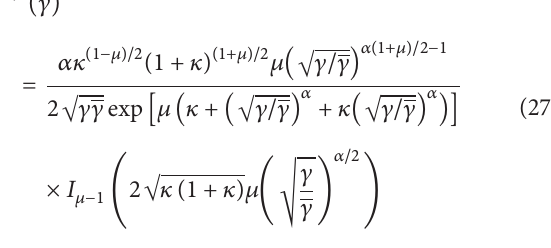
/𝑁 where 𝛾 = 𝜌 2 𝐸 0 is the SNR for a particular value of the b /𝑁 envelope 𝜌 , 𝐸 0 is the ratio between the average energy b per bit and the noise power spectral density, and erfc (⋅) is the complementary error